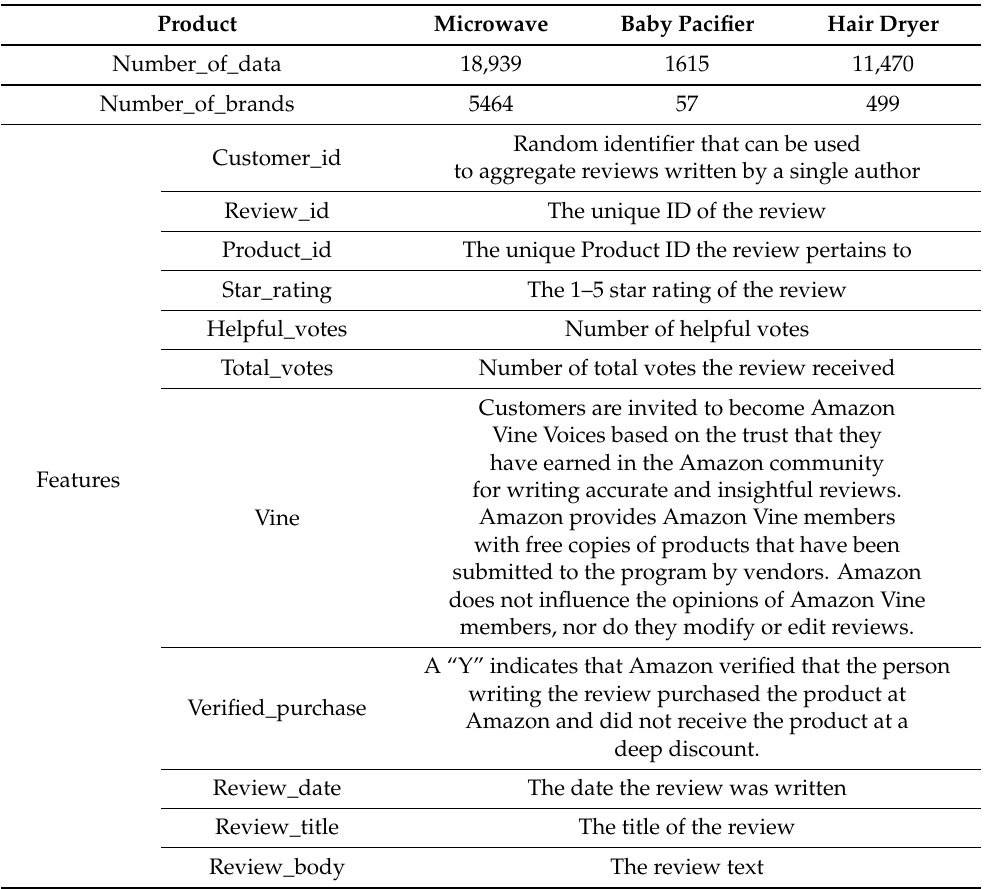
Table 2. Amazon review dataset.